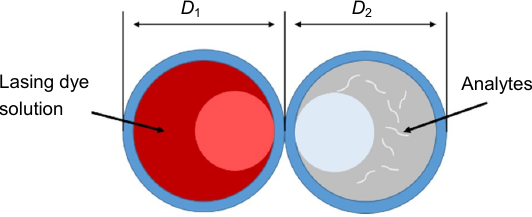
Fig. 4 | The illustration of the coupled liquid-core